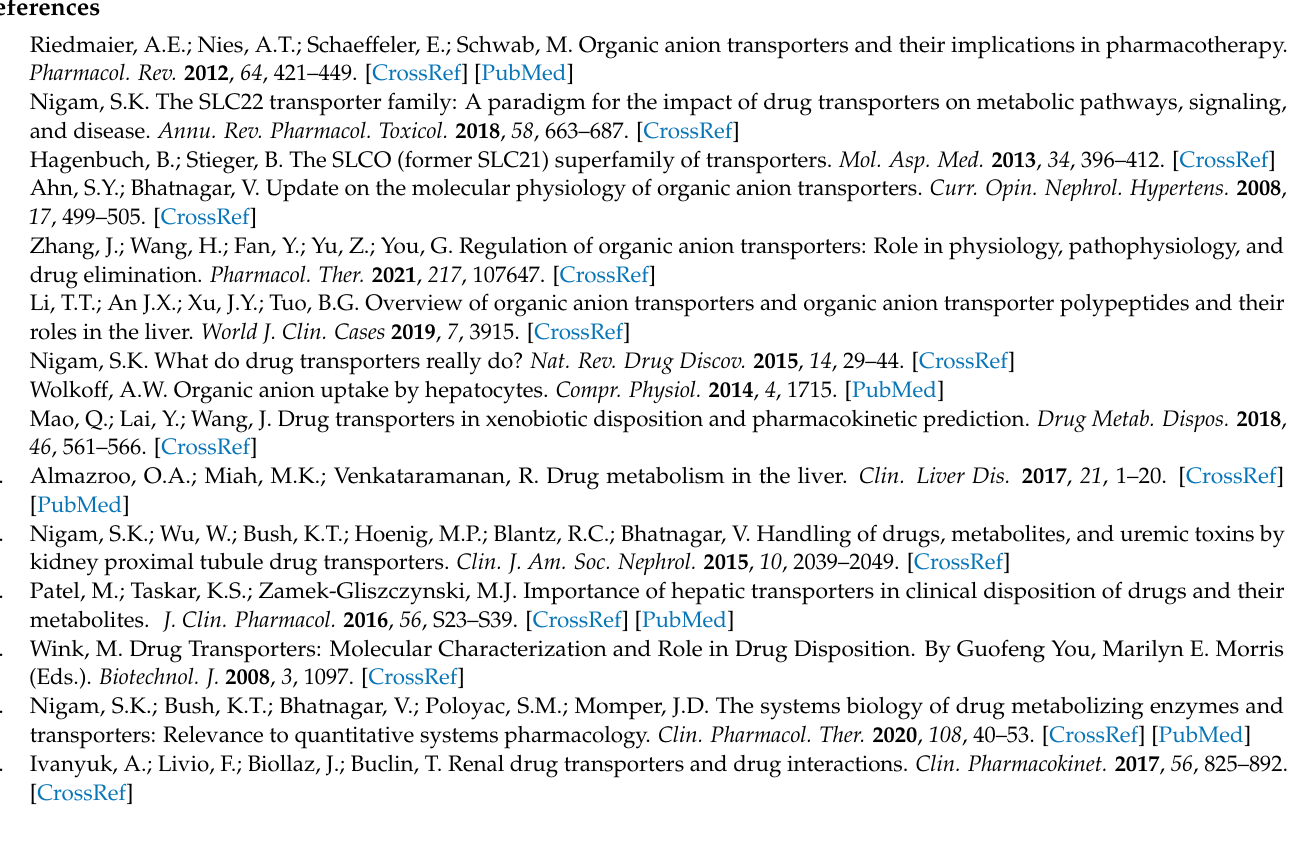
Figure S1: Correlation Heatmap: Graphical representation of correlation matrix representing correla- tion between different features, Figure S2: Heat map of selected nodes corresponding to the decision tree (Figure 4), Figure S3: Diagram of a neural network corresponding to Figure